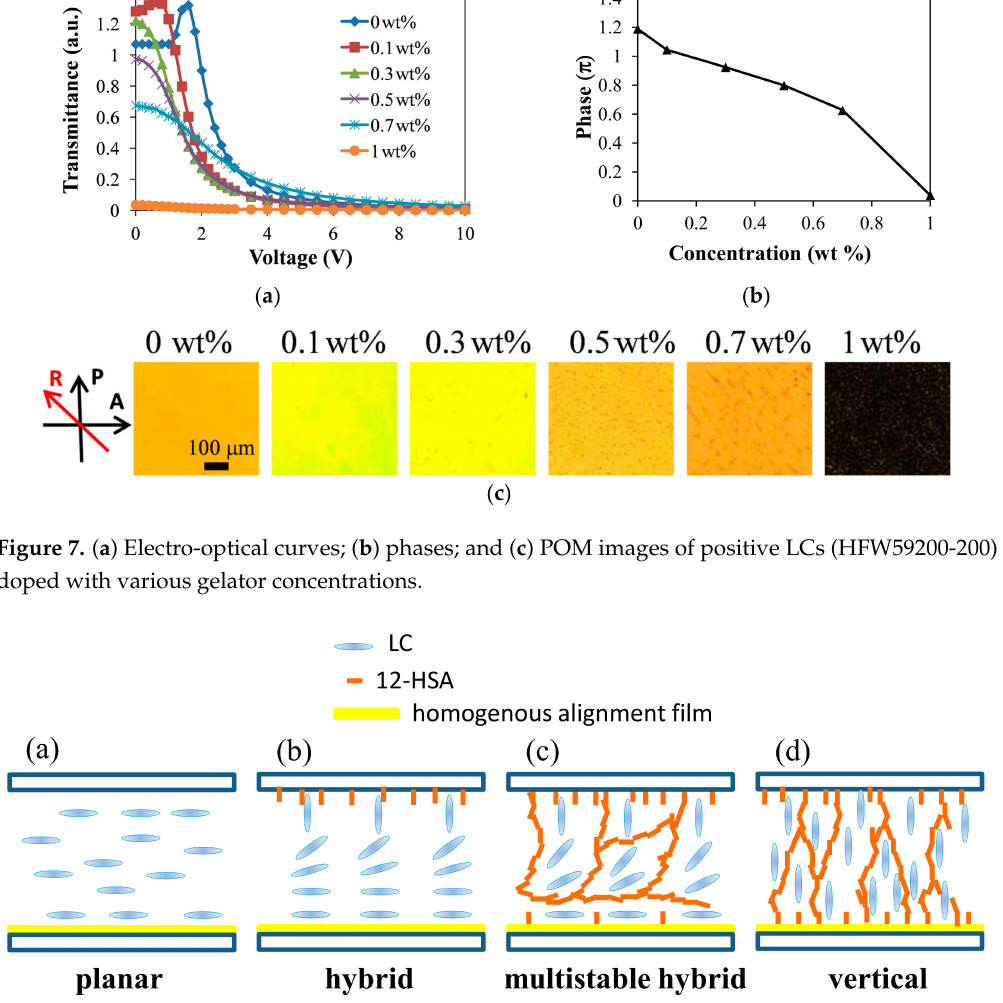
Figure 8. Schematics of LC orientations after doping with the gelator. ( a ) Planar, ( b ) hybrid, ( c ) multistable hybrid, ( d ) vertical